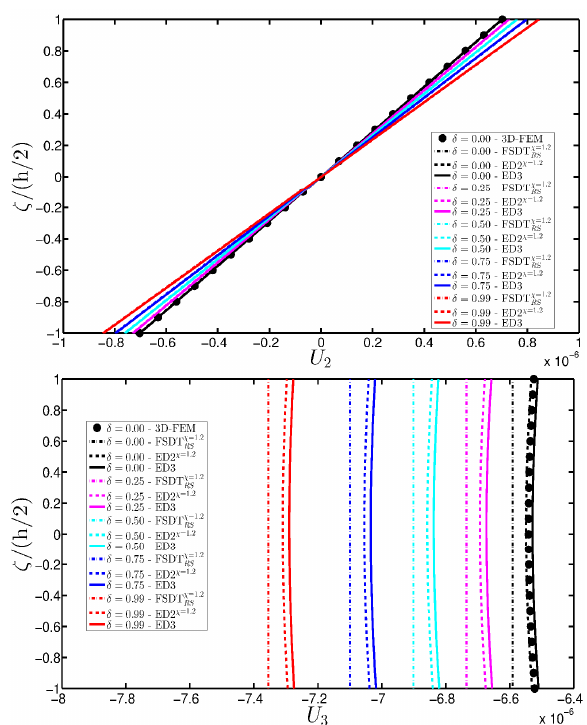
Figure 9. Through-the-thickness profiles of displacement components [m] for the CCCC isotropic square plate computed at the point A for different HSDTs. The effect of the damage is investigated by varying the parameters of the function Gau-2.